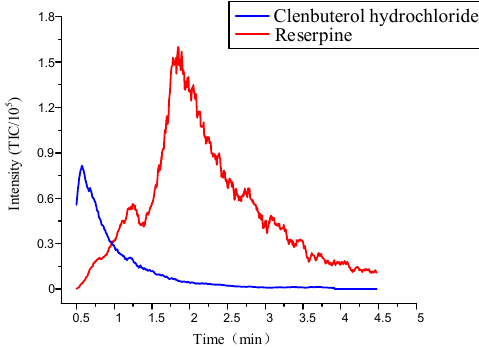
Figure 9. The elution curve of multiple compounds under the optimal elution conditions.